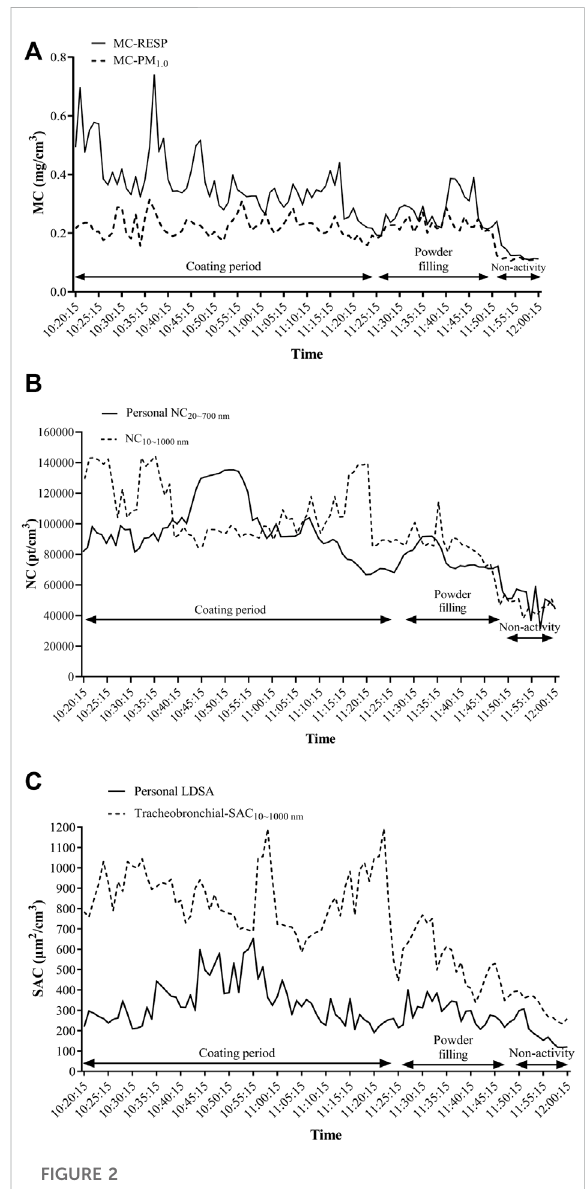
FIGURE 2 Temporal variations in the concentrations of the UFPs covering one complete work cycle. (A) Temporal variations in the MC; (B) Temporal variations in the NC and personal NC of particles; (C) Temporal variations in the SAC and personal SAC of